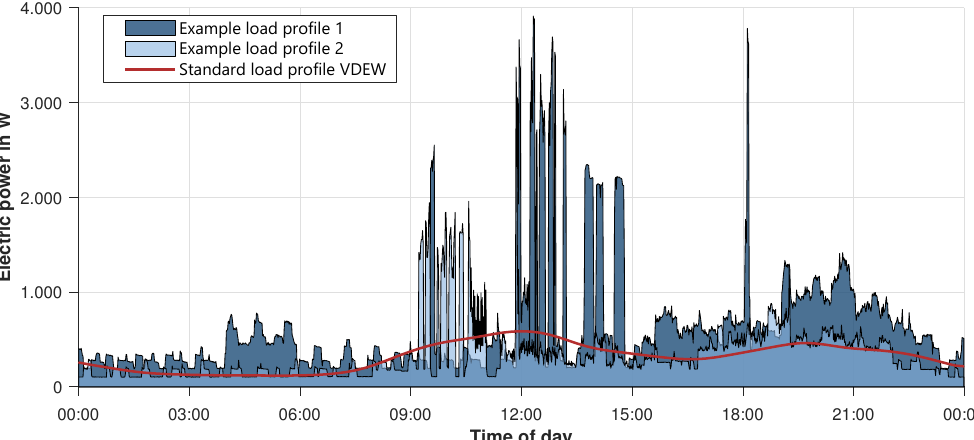
Figure 8. Exemplary synthetic load profiles in comparison to the German standard load profile of households.